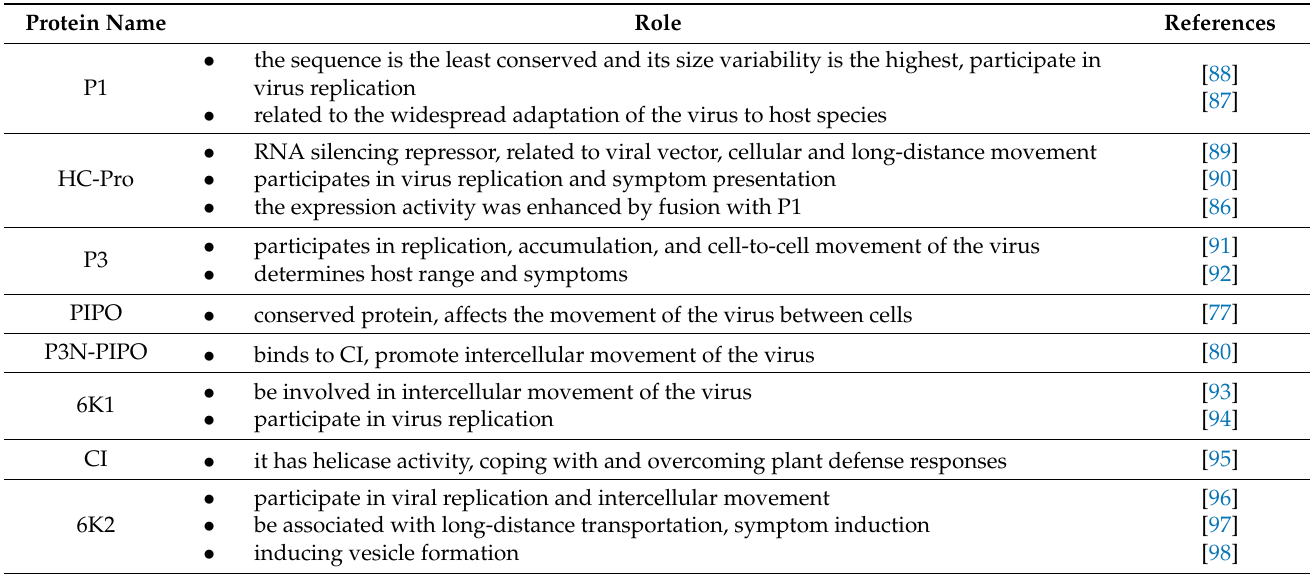
Table 2. The main role of 12 functional proteins of Potato virus